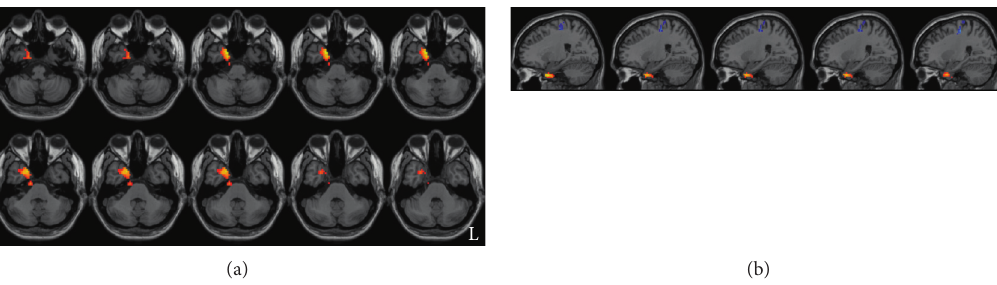
Figure 2: Increased ReHo in the right temporal pole in RPD patients compared to the controls. (a) and (b) are axial and sagittal views, respectively. L indicates the left side.